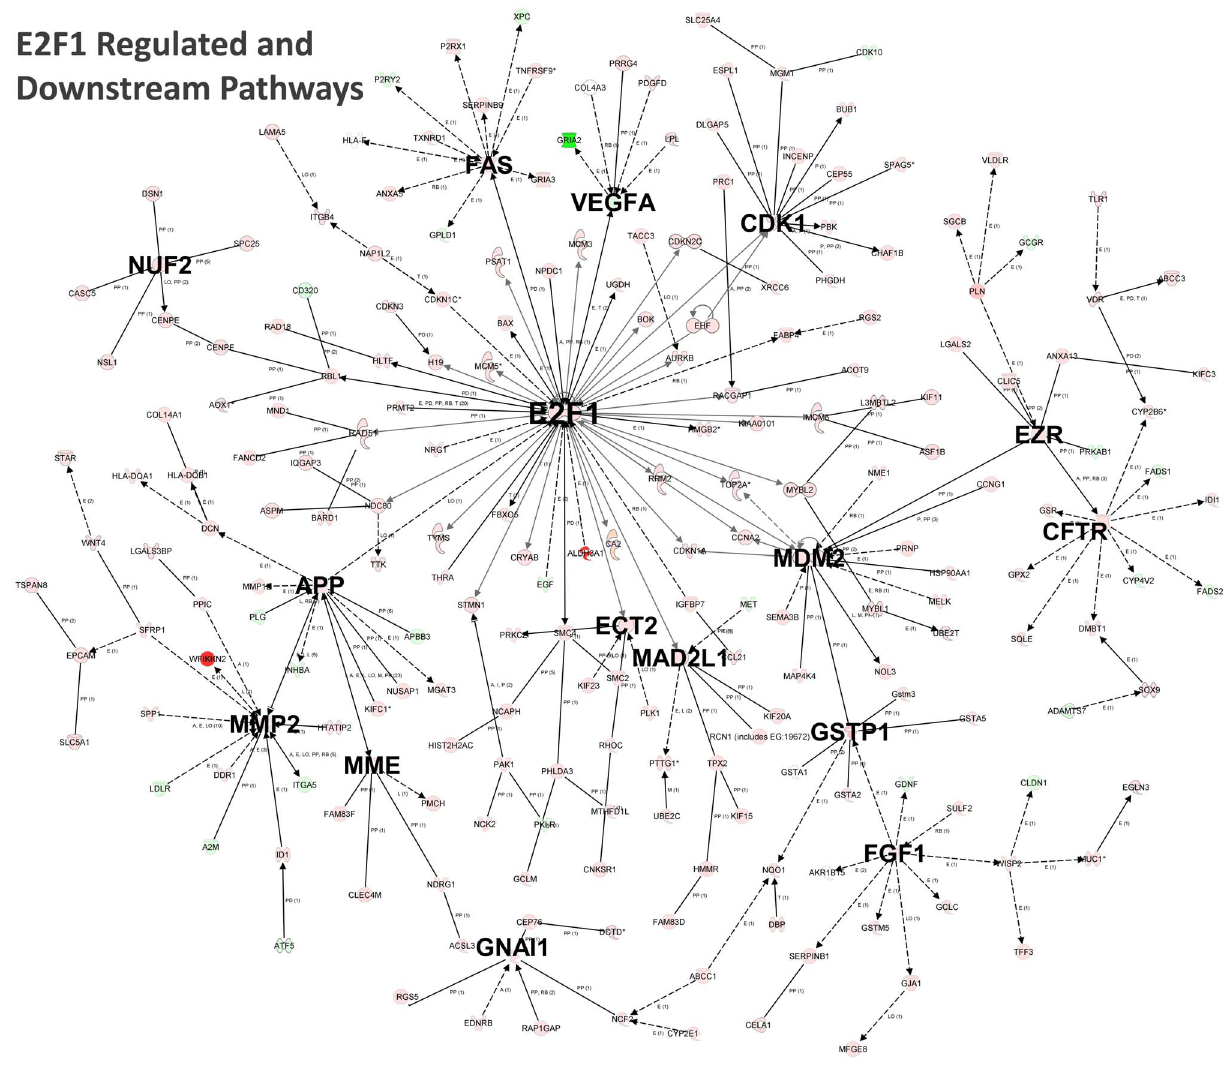
Figure 8. E2f1 regulated and downstream pathways altered by AFB1. AFB1 produced DEGs from DESeq analysis of RNA-Seq data which were analyzed by the IPA’s ‘grow pathway’ analysis (Ingenuity Pathway Analysis) which displays annotated regulatory relationships and interactions. Starting with induction of E2f1 in the center, DEGs from DESeq analysis were used to connect and grow downstream-dependent genes (red, upregulated; green, down-regulated). Hub genes (bolded, enlarged gene symbols) were defined as those transcripts regulating or interacting with $ 5 transcripts.